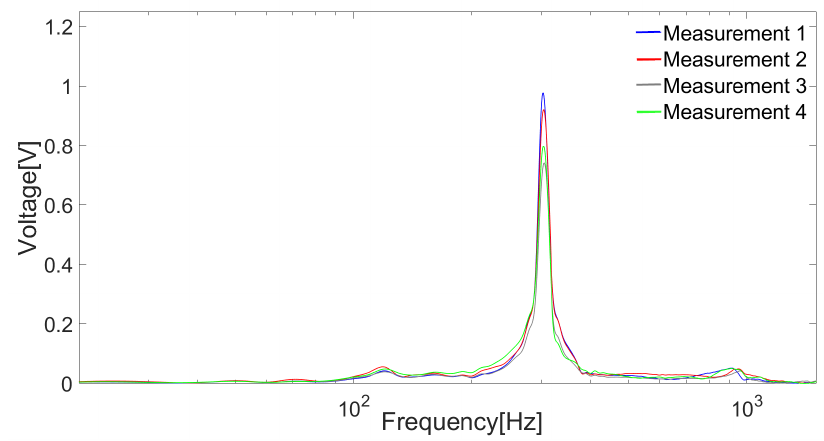
Figure 9. Fourier transform of the Open-circuit output voltage for the computation of the resonant frequency of the bimorph beam with tip mass (model B).